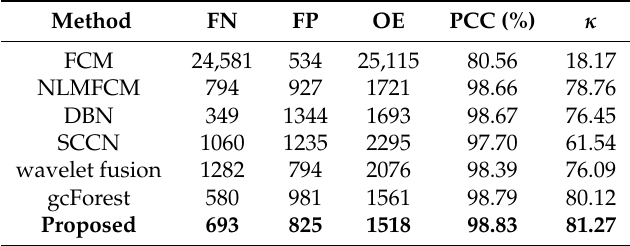
Table 3. Value of the evaluation criteria of the inland water data